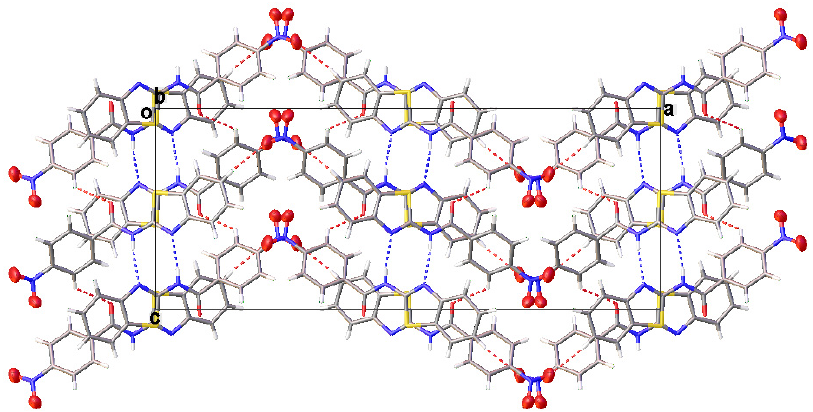
Figure 6. A partial view of the crystal packing of III depicting a herringbone packing pattern .